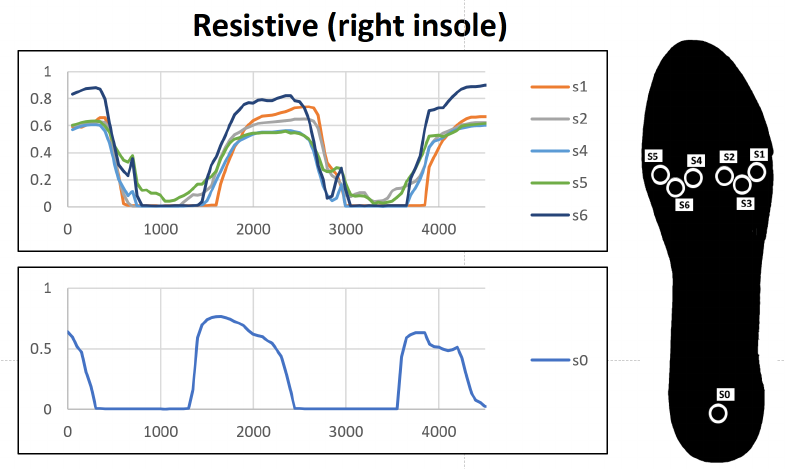
Figure 11. Behaviour during user gait—resistive